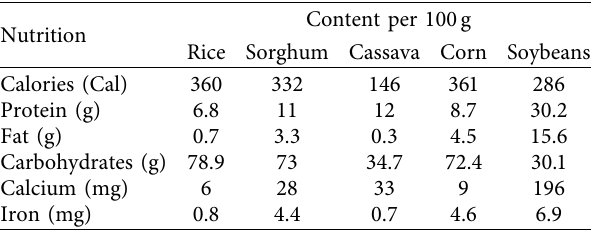
Table 2: Nutrition values of sorghum compared to other crops.